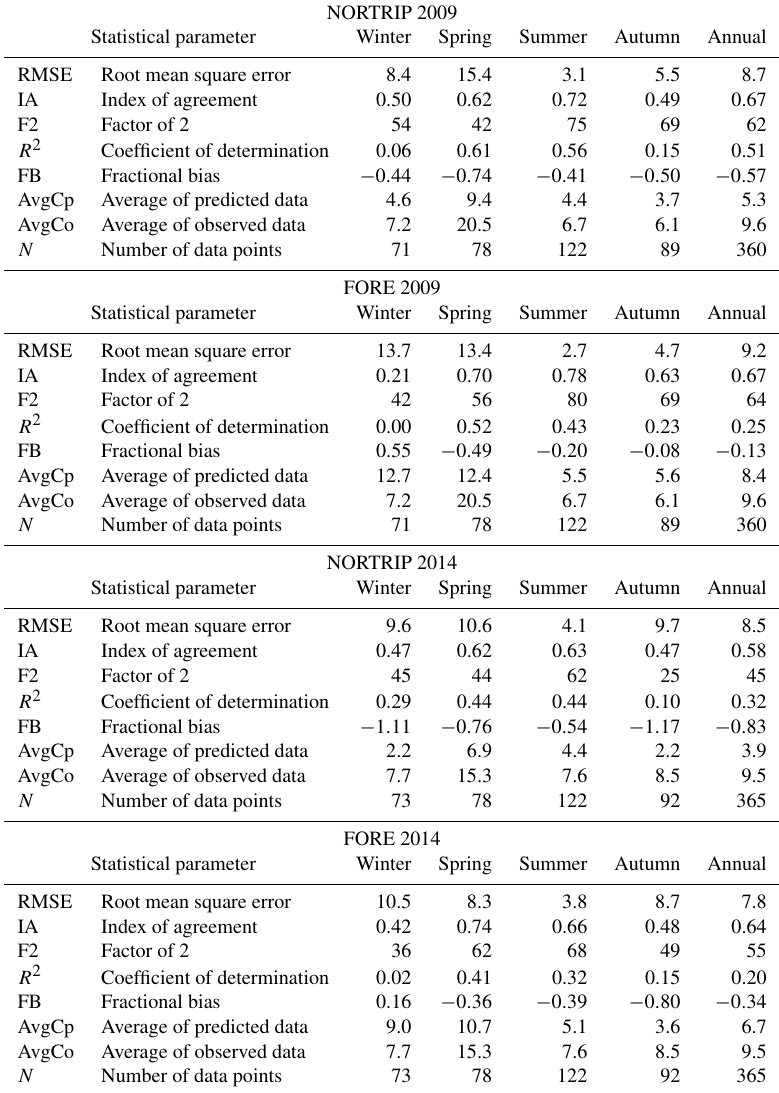
Table A1. Statistical values for the modelled daily mean street increment of PM 10 for the NORTRIP and FORE models for 2009 and 2014, calculated on an annual and seasonal